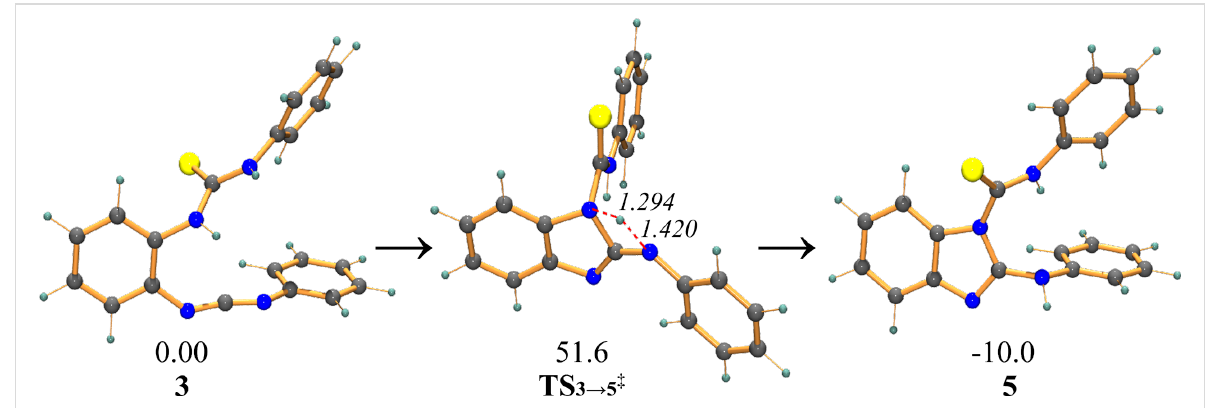
Figure 2: Optimized structures of 3 , TS 3 → 5‡ and 5 at B3LYP/6-31+G*. Free energies are reported in kcal mol − 1 at 25 °C and distances are shown in angstrom (italics).